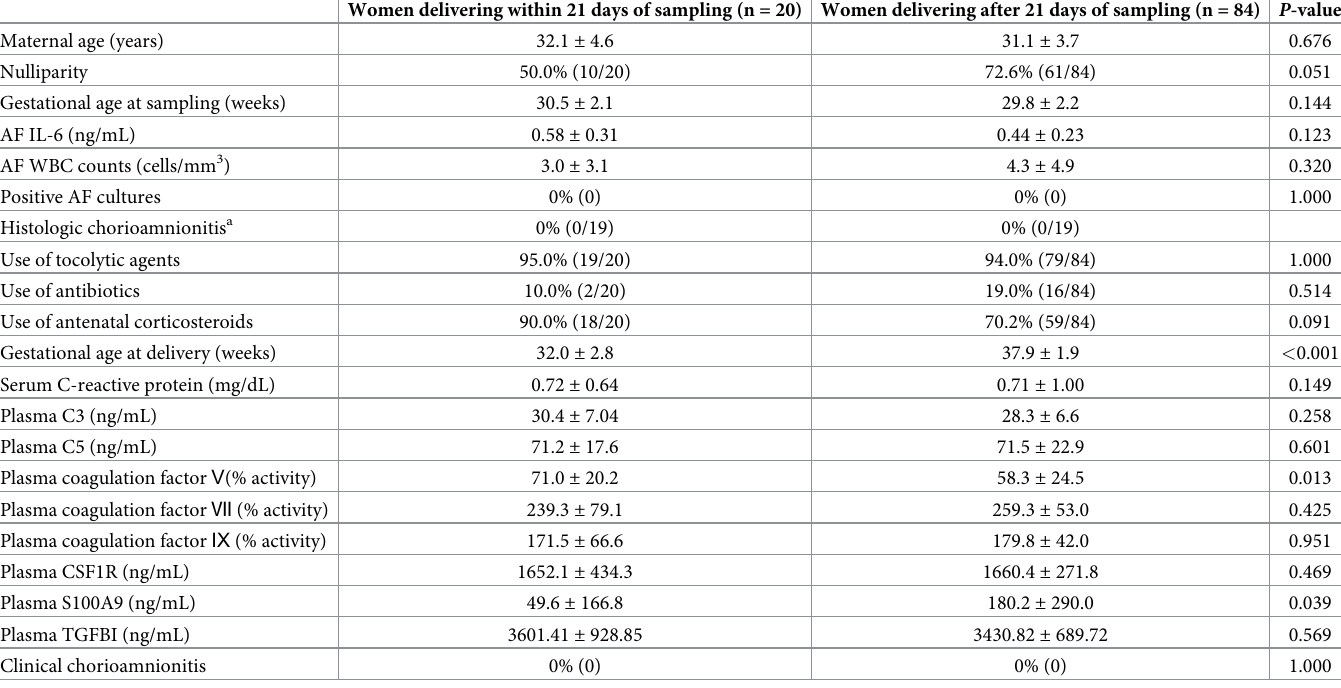
Table 1. Demographic and clinical characteristics along with candidate proteins of interest in participants comprising the total cohort based on the occurrence of spontaneous preterm birth within 21 days of